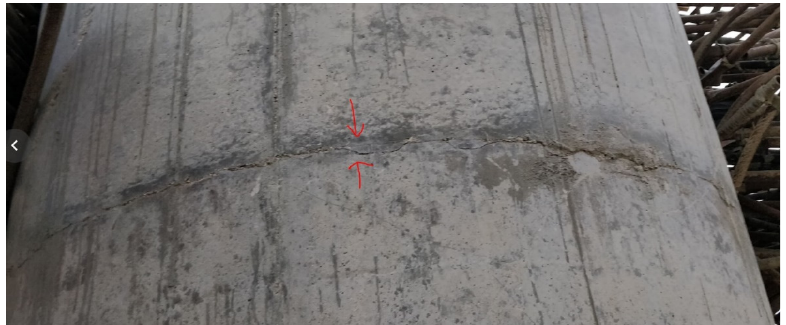
Figure 21. Horizontal crack towards the Span-1 side of Pier-1, at 2.5 m height from the ground level.